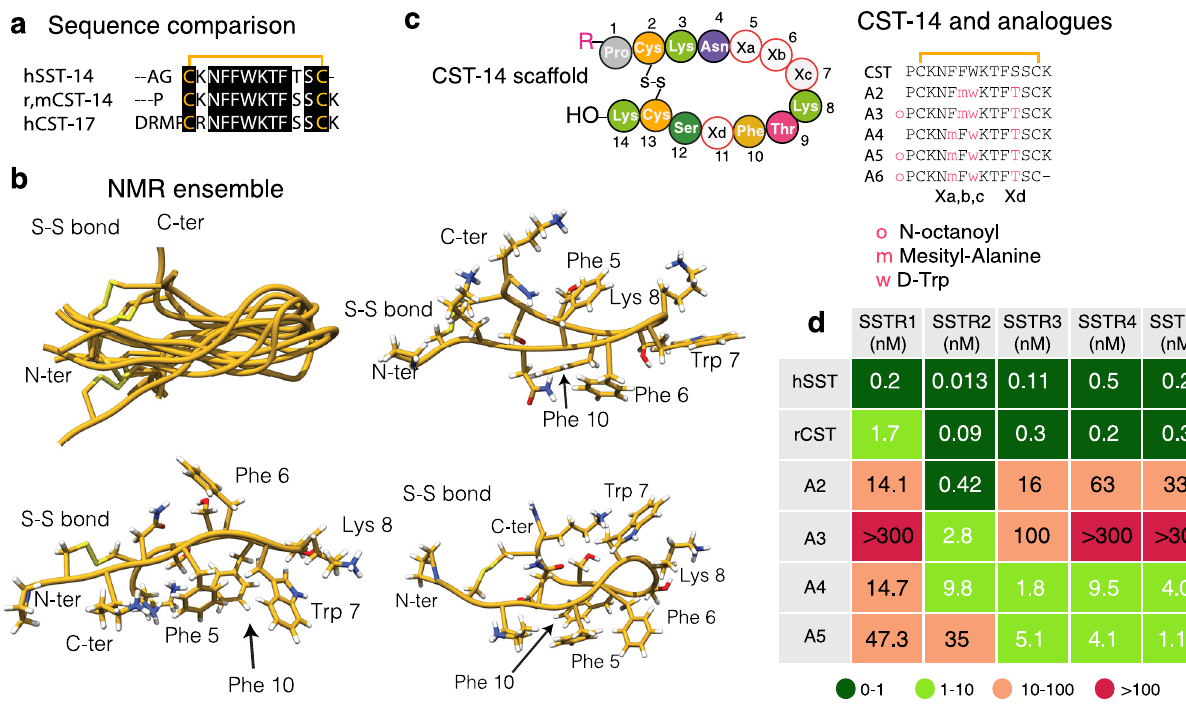
Fig. 1 Cortistatin and Somatostatin sequence comparison, analogue design and NMR conformers. a Sequence comparison of human Somatostatin (SST) to rat, mouse and human Cortistatins (CST). b Backbone superposition of the 10-lowest energy conformers. The peptide backbone is shown in gold and the N- and C-terminus residues, as well as the disul fi de bond are labelled. Representative aromatic clusters. All side chains are shown to facilitate structural analysis. Side chains participating in the interactions are speci fi cally labelled. c Schematic representation of Cortistatin-14 sequence. Positions Xa, Xb, Xc and Xd have been mutated to prepare the analogues. Native CST was also synthesised for the NMR and functional studies. Sequences of the analogues prepared in this work. Substitutions are coloured. Synthetic scheme is displayed as Supplementary Fig. 1a. d Schematic representations of the relative af fi nities of SST, CST and analogues A2-A5 for the different Somatostatin receptors (SSTR1-SSTR5) Supplementary Fig. 1b. The relative af fi nities are represented based on the determined IC 50 values. The values are collected as Supplementary Table